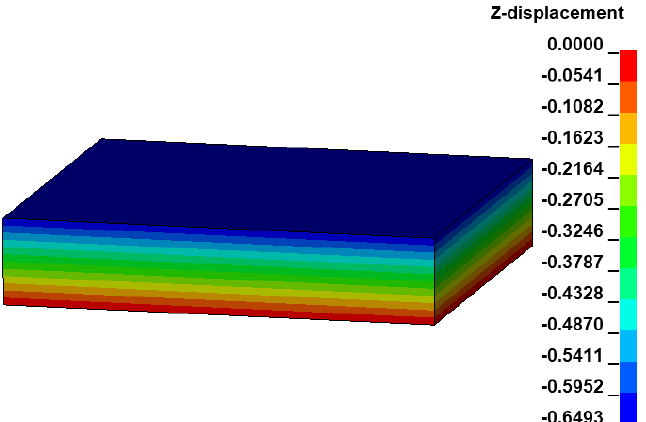
Figure 7. Deformation of the linear brick element under prescribed biaxial tension on the XY plane for the specimen